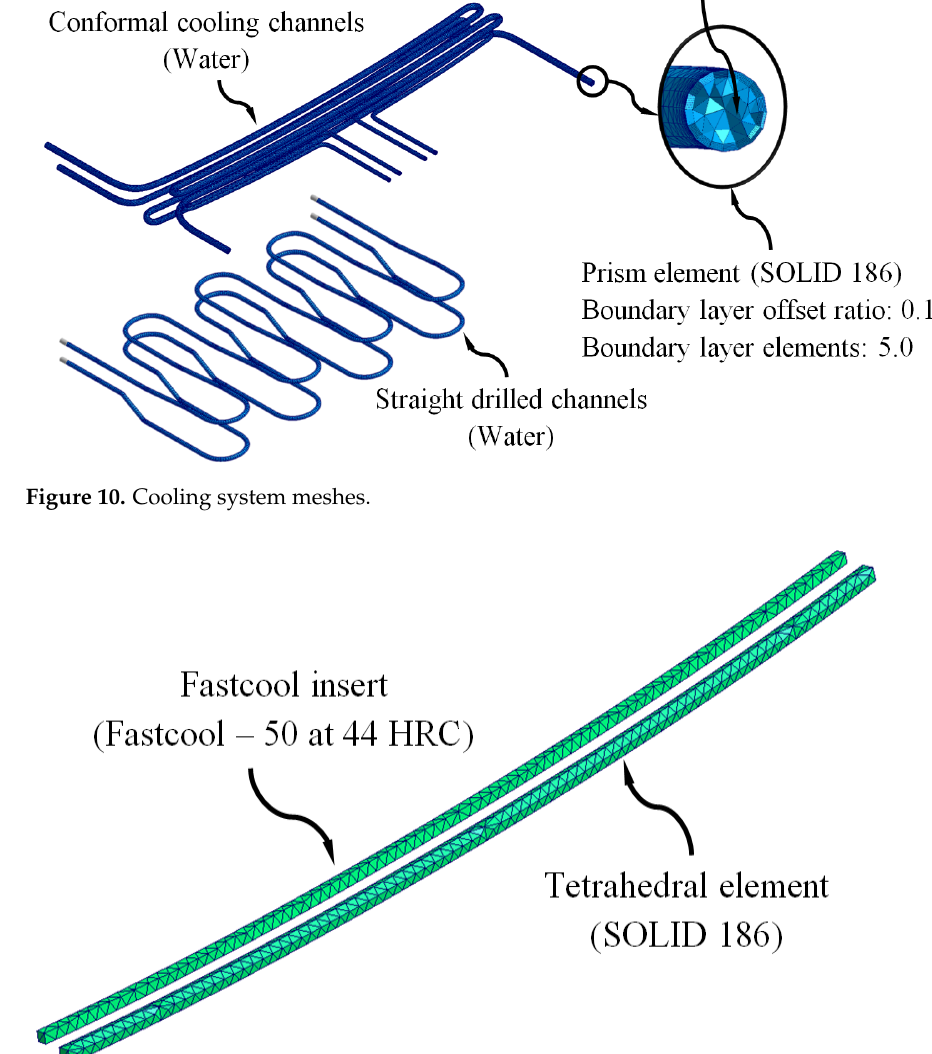
Figure 12. Plastic part and filling system meshes. On the other hand, after the meshing phase, the magnitude of the thermal, rheologi- cal, and technological parameters of the boundary conditions was established. The defi- nition of these parameters allowed for the simulation of each of the different phases in which the manufacturing cycle of the plastic part is divided. In this way, it was possible to model the path of the molten plastic front, along with the feeding system and injection mold cavity, the crystallization and solidification of the thermoplastic material, the pack- ing process of the plastic part, and its subsequent cooling. Table 9 shows the magnitude of each of the defined parameters according to the specifications and recommendations